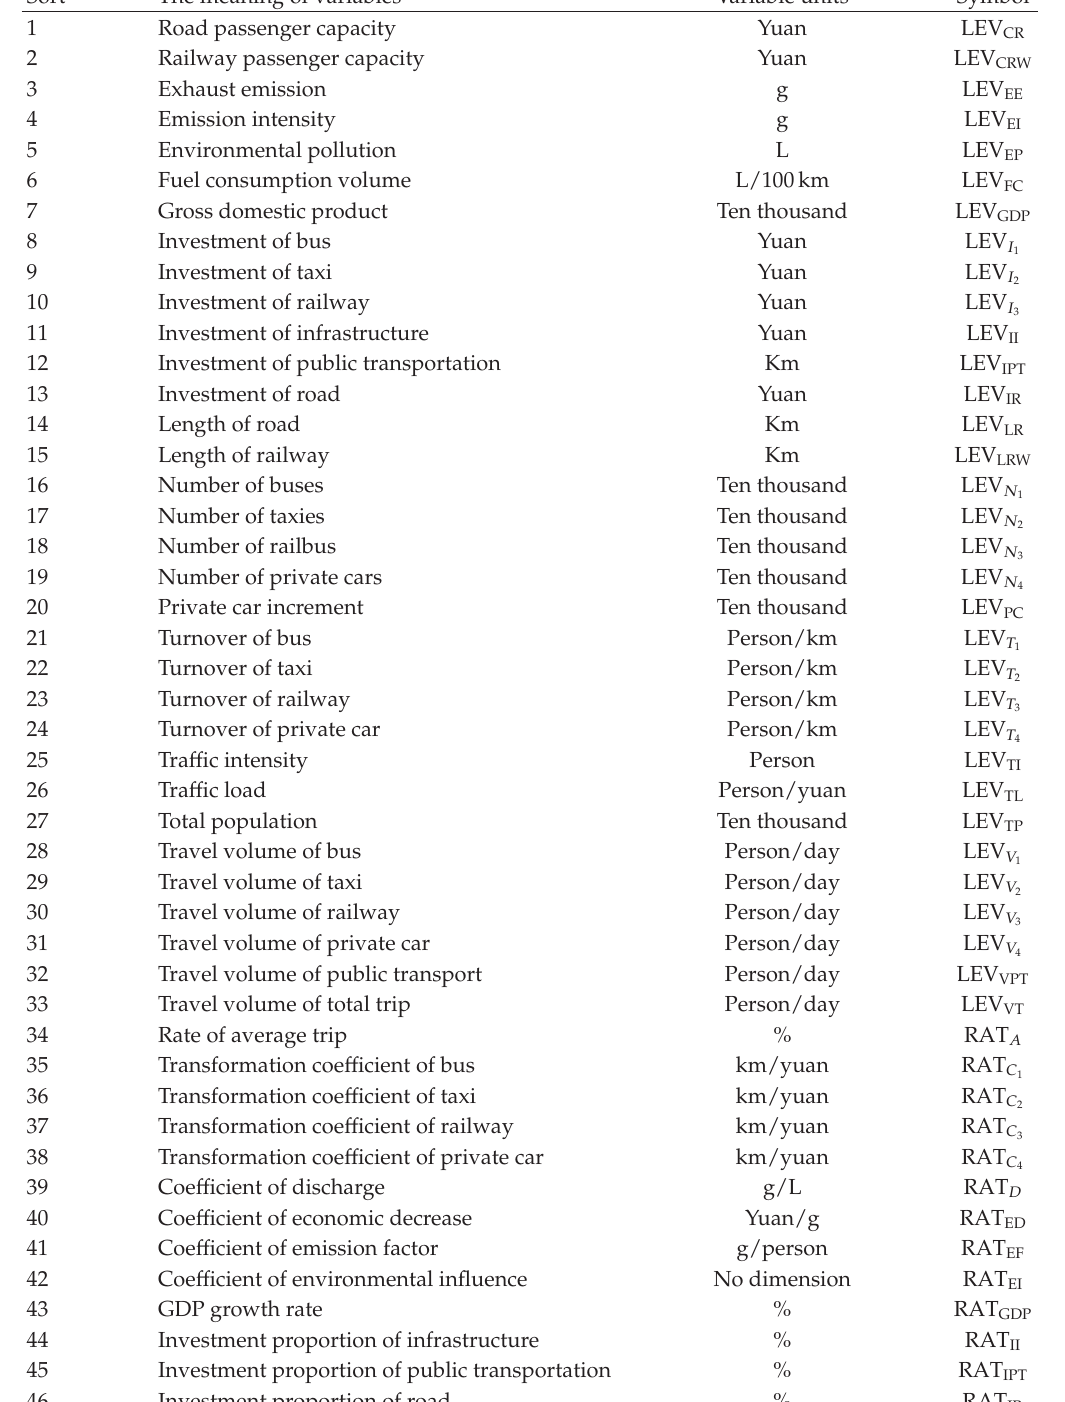
Table 1: Variables and symbols in garden city transportation